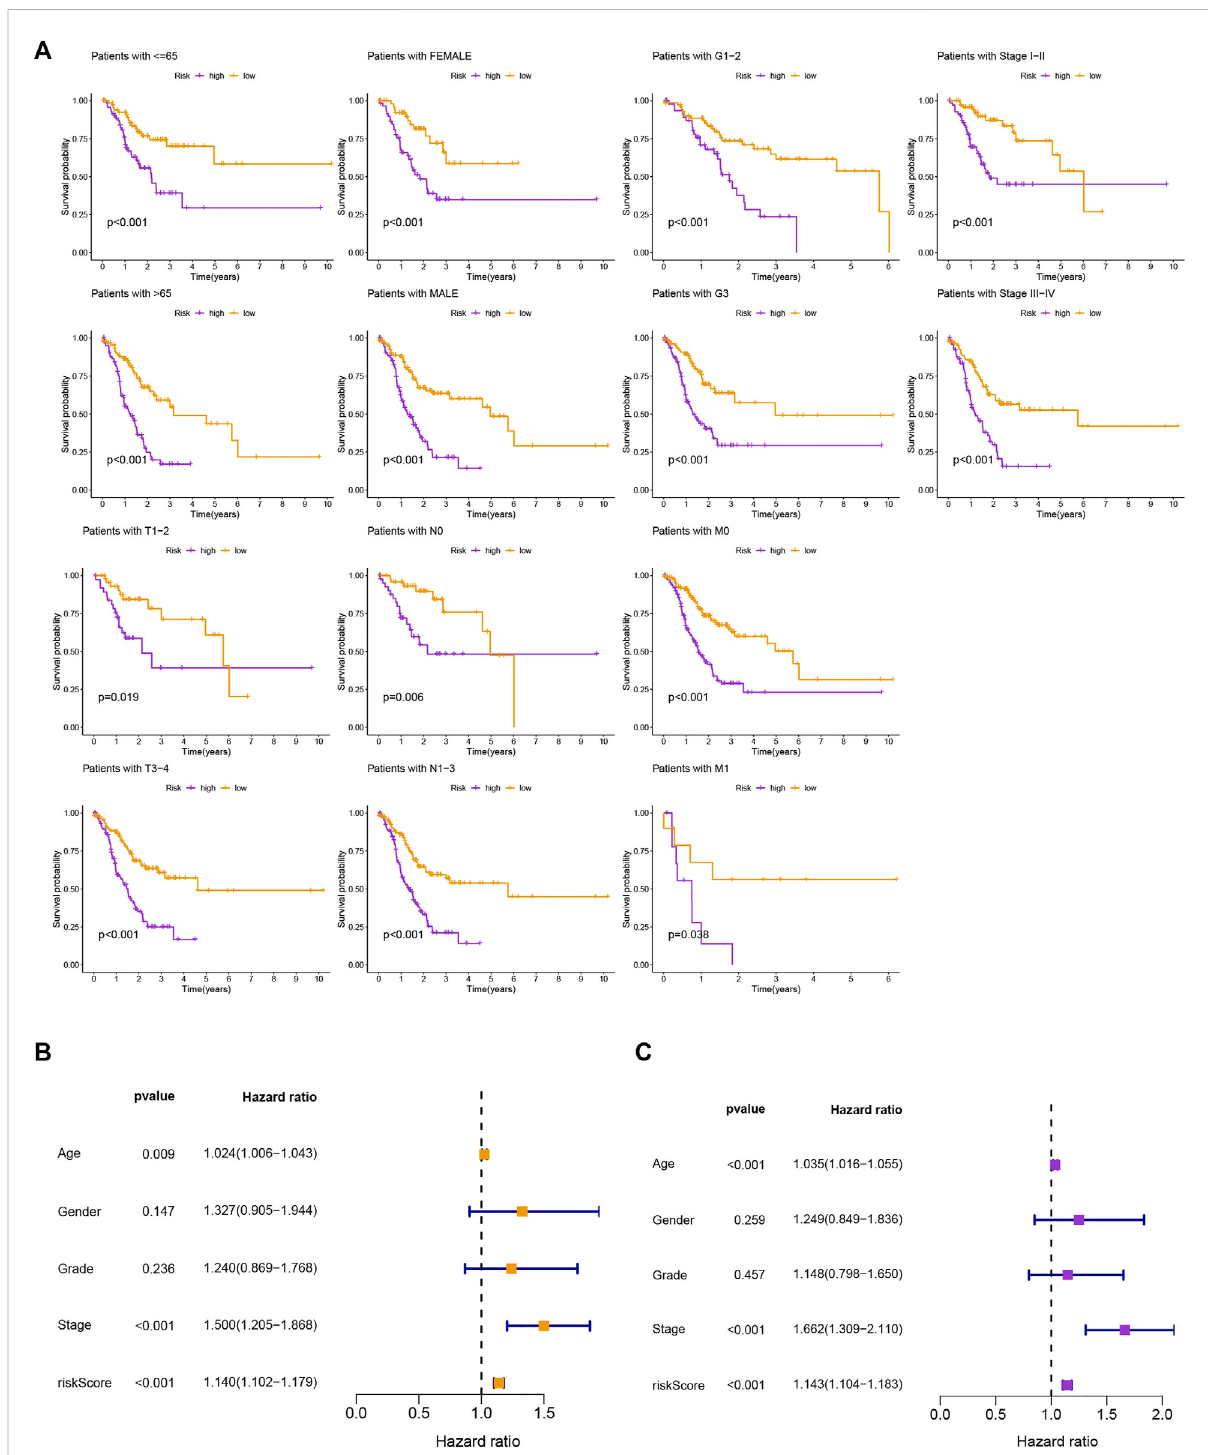
FIGURE 3 Kaplan-Meier curves of SP and PCAbetweentwo groups. (A) Kaplan-Meier curves of SP differences strati fi edby age, gender,clinical stage,or T stage between different risk groups. (B,C) Univariate and multifactorial Cox analyses showed that risk score is a risk factor for individual